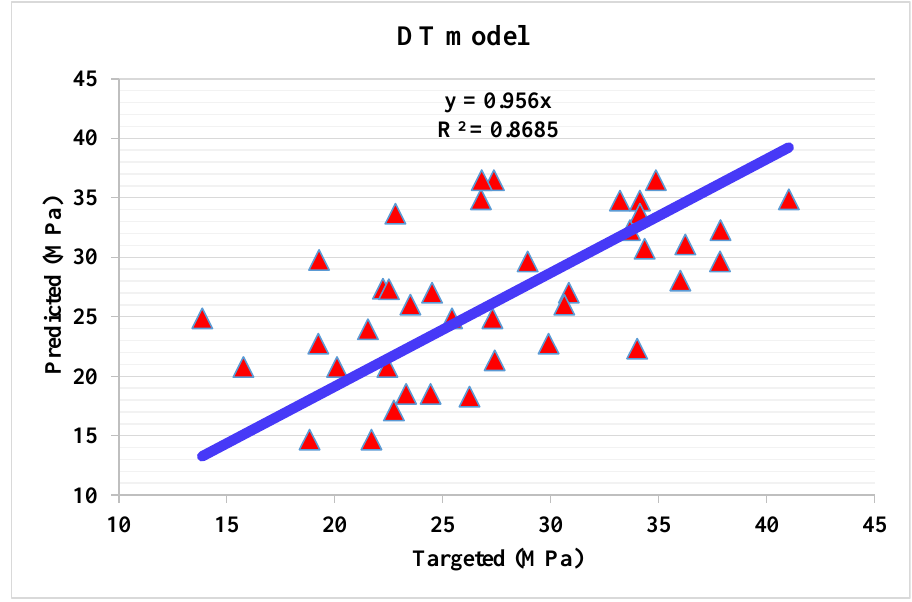
Figure 10. Predicted and actual results of DT model.